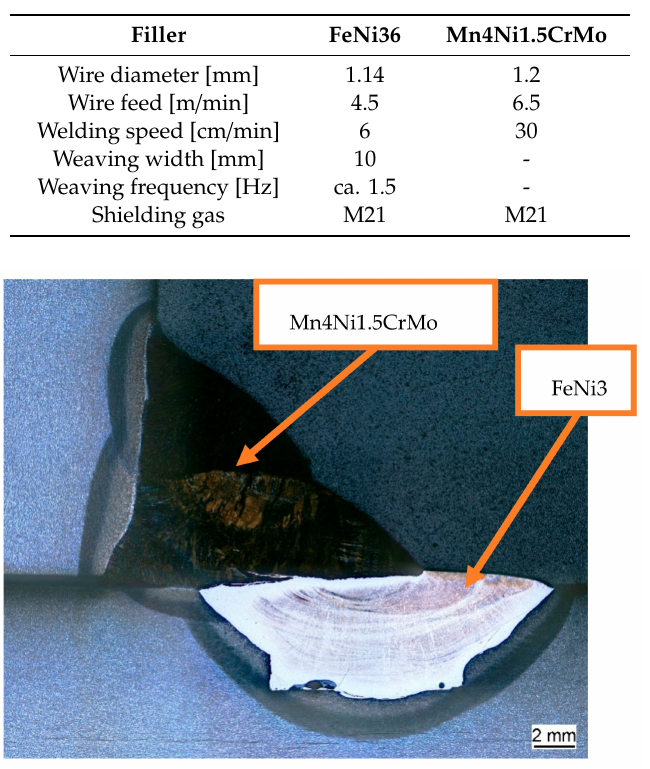
Figure 8. Metallographic grinding of the modified fillet